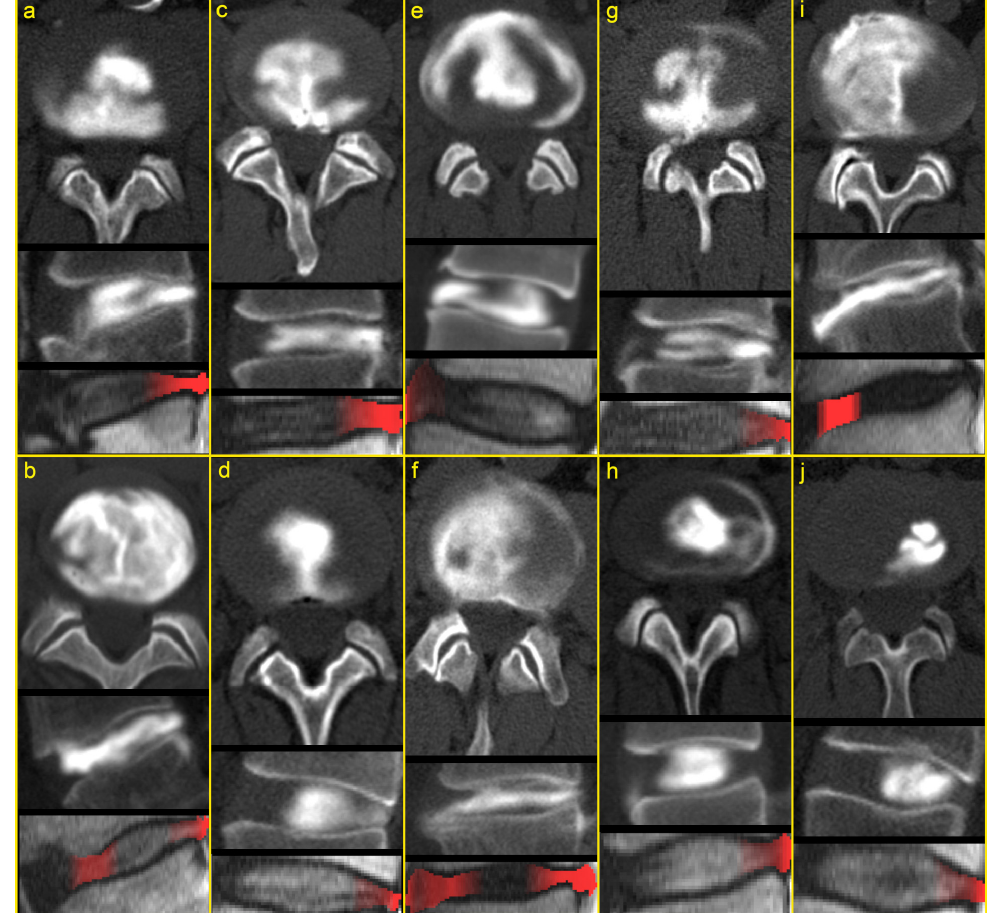
Figure 4. Representative examples of computed tomography (CT) discograms (top and middle) and the corresponding attention maps overlaid on a sagittal T2-weighted MR image (bottom). The sagittal images display the ventral intervertebral disc (IVD) on the left and dorsal IVD on the right. The figure displays instances where the attention maps correctly identify all the outer annular fissures ( a – f ) and fail to do so ( g – j ). The contrast media, injected into the nucleus pulposus (visible in white), spreads through annular fissures and their position is determined by the proposed algorithm in the T2-weighted image and highlighted in red. ( a , c , d ) Examples of IVDs with dorsal fissures. ( b ) Diffusely degenerated IVD with an annular fissure reaching the outer 1/3 of the dorsal